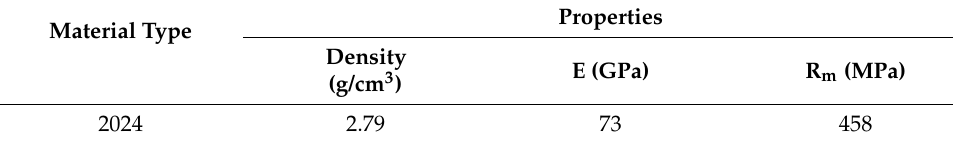
Table 13. The properties of the constituent materials of the